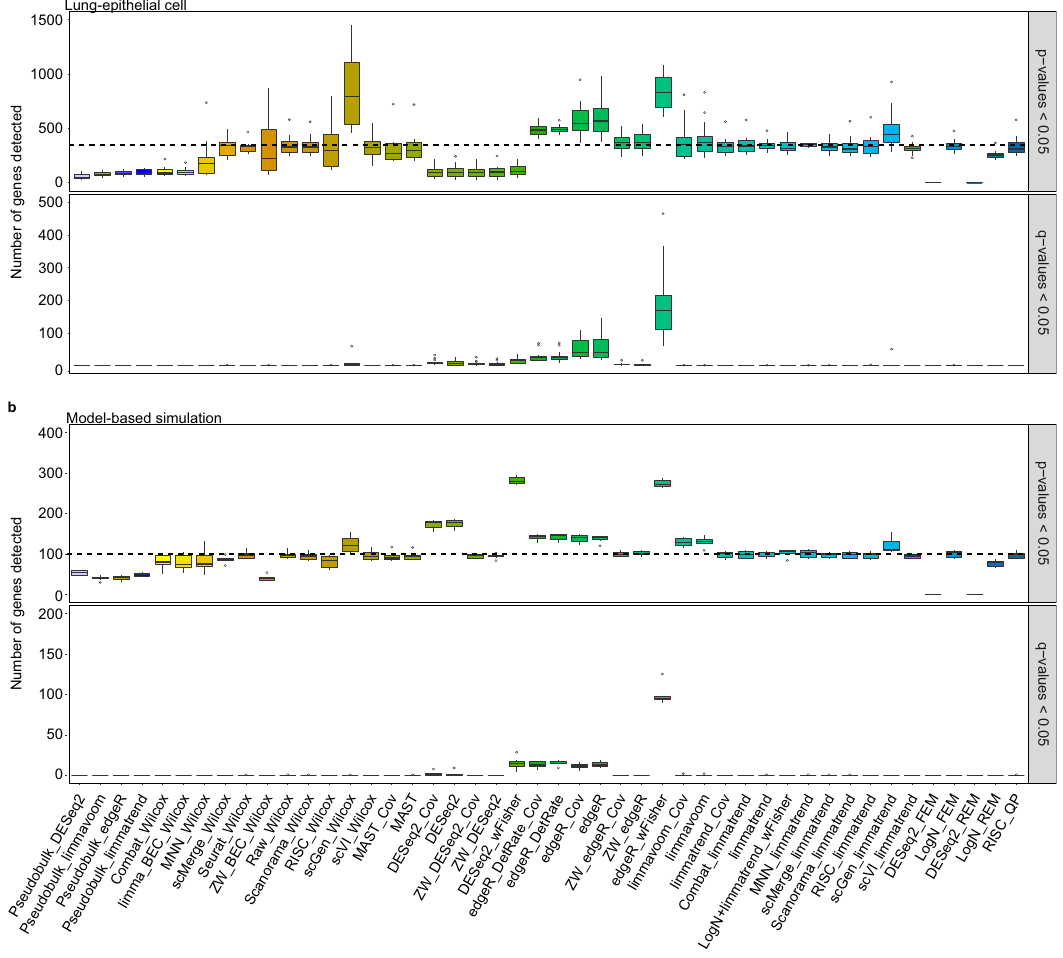
Fig.5|Comparisonoffalsepositivecontrols( p -value<0.05)andfalsediscovery controls ( q -value <0.05) between differential expression work fl ows (gene fi l- tering: zerorate> 0.95). Test resultsfor a sevenbatchesof normallung epithelial cells and b seven batches of model-based simulation data are shown as boxplots;